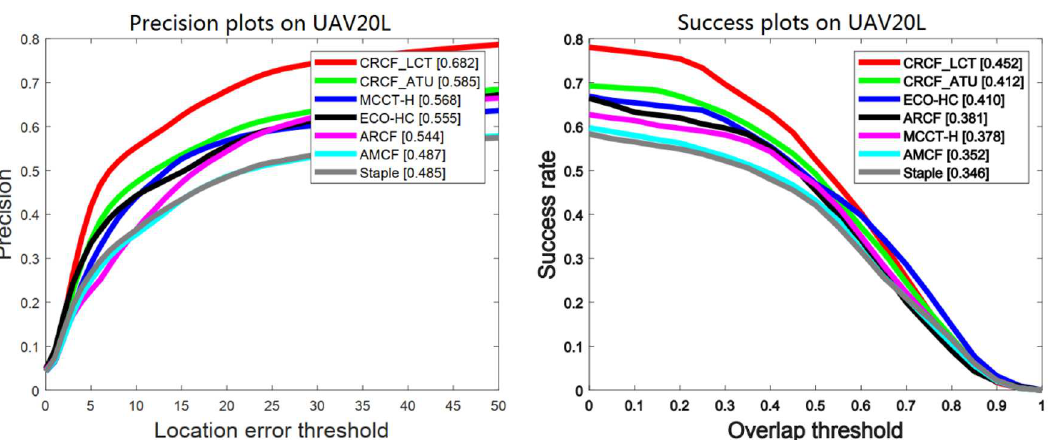
Figure 11. Comparison between CRCF_LCT tracker and existing trackers on